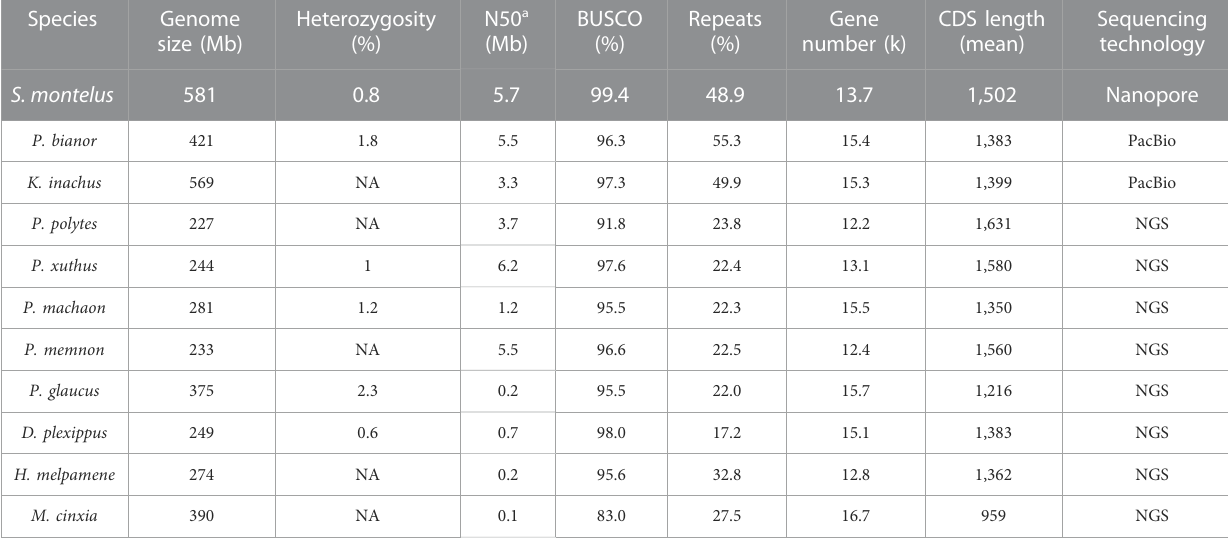
TABLE 3 Comparison of basic characteristics of S. montelus genome assembly and annotation with published butter fl y genomes. Species